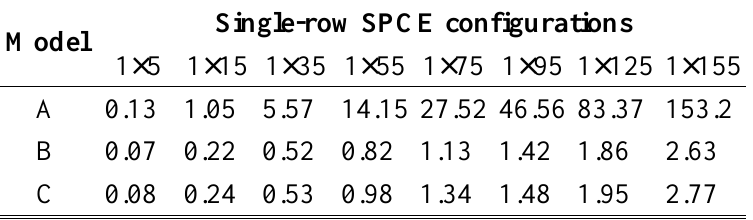
Table 1. Elapsed time in sec of the ego-translation for different single-row SPCE configurations with three models under a noise level of variance